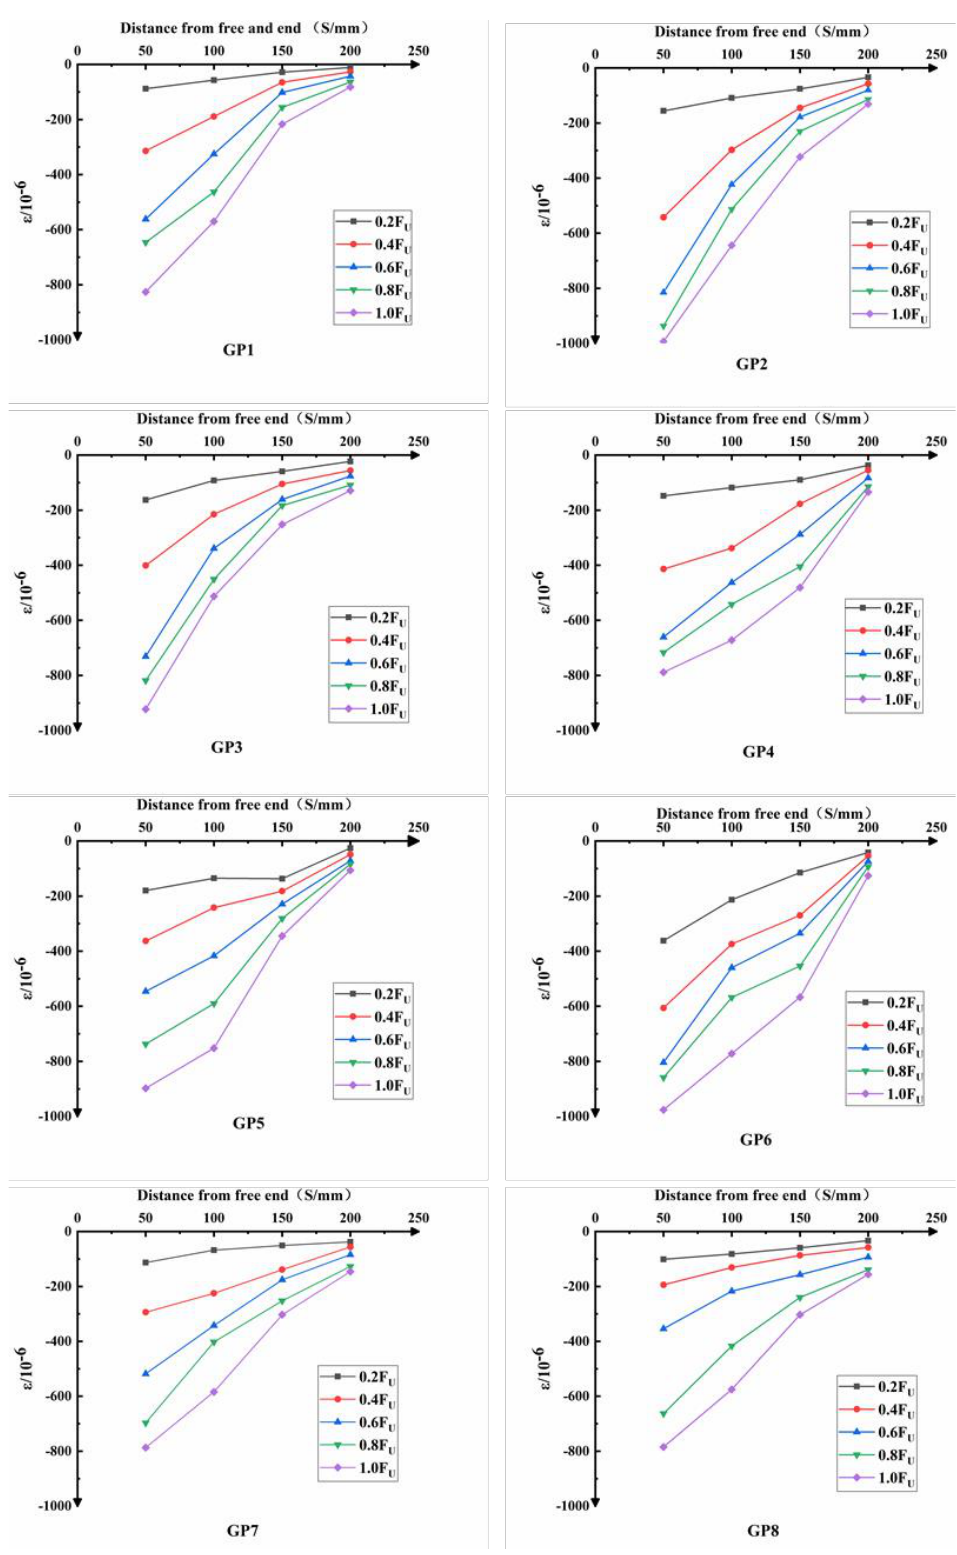
Figure 7. The curve of longitudinal strain distribution of CFST. Note: F U means the ultimate bonding load.